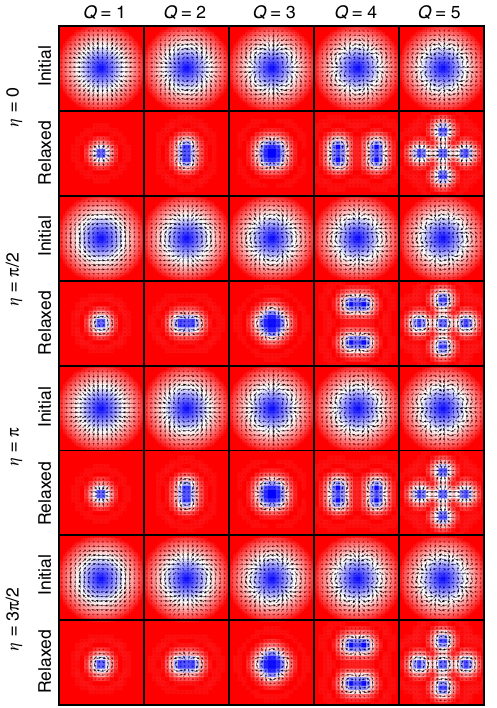
Fig. 2 Relaxed states of skyrmions with different values of Q and η . We construct a radial symmetric skyrmion as the initial state and check whether the initial geometry is preserved or destroyed after the relaxation. The model is a square element (40 × 40 spins) with the OBC. The parameters are J 2 = − 0.8, J 3 = − 1.2, K = 0.1, and H z = 0.1 similar to those of the skyrmion as shown in Supplementary Fig. 12. Binary stable skyrmions and antiskyrmions . The skyrmion energy and the antiskyrmion energy are degenerate and inde- pendent of the helicity η in the absence of the DDI (cf. ref. 41 ). We